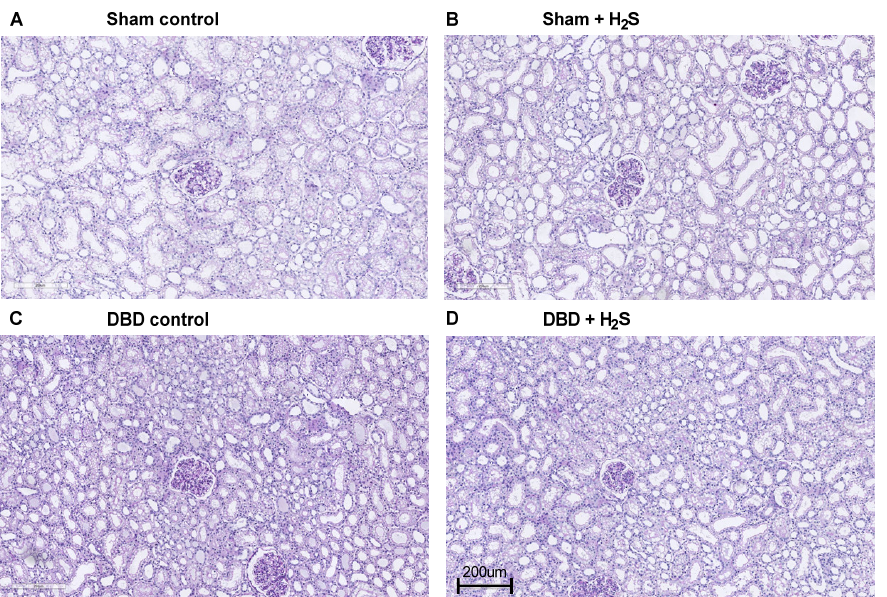
Figure 6. Representative histopathological images.